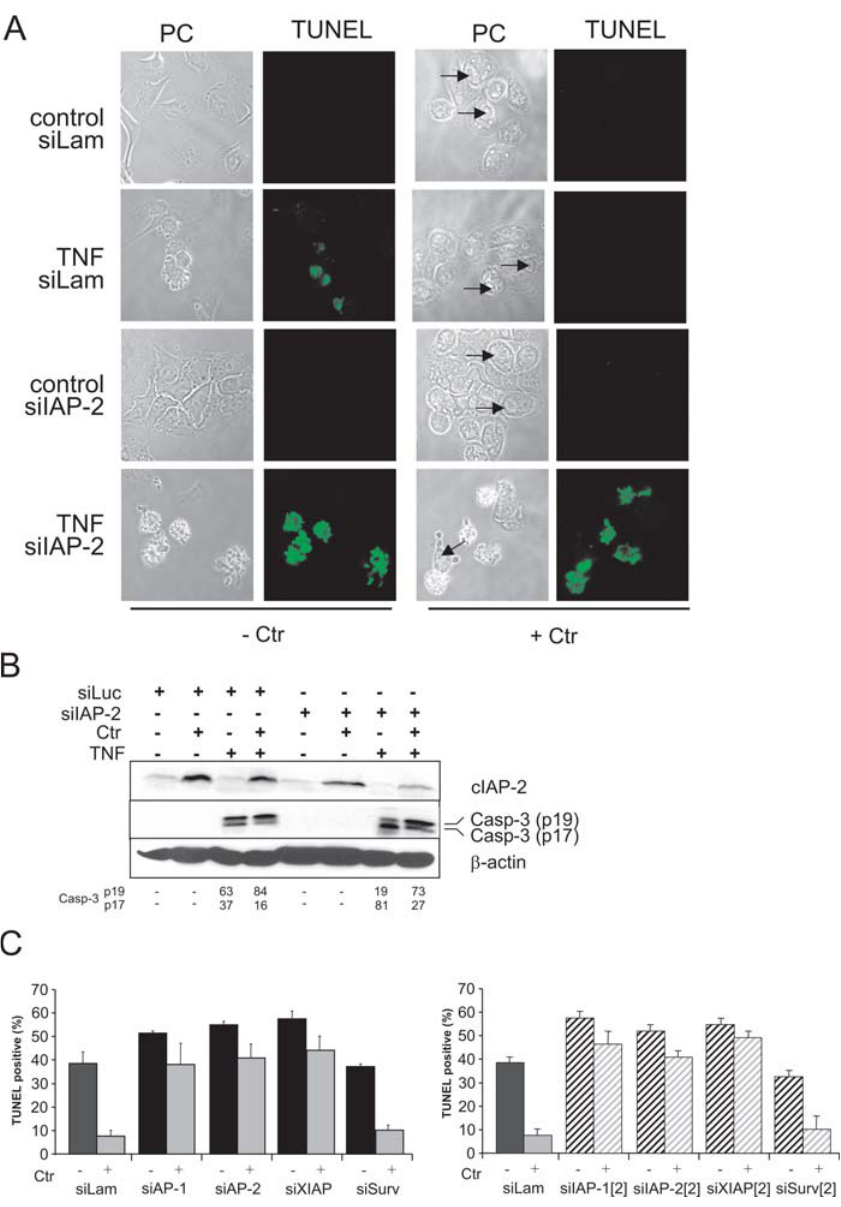
Figure 3. IAPs Required for Infection-Induced Apoptosis Resistance (A) HeLa cells were transfected with control siRNA (siLam) or siIAP-2 and infected ( þ Ctr) or not ( (cid:1) Ctr) with Ctr. Then, apoptosis was induced by treatment with TNF/CHX, and the apoptotic response was measured by phase contrast (PC) and TUNEL analysis. Arrows point to Ctr inclusions. (B) Infection-induced up-regulation of cIAP-2 prevents the processing of the caspase-3 p19 to the p17 fragment. HeLa cells were transfected with siRNAs, infected, and treated with TNF/CHX as indicated. cIAP-2 and the p19 and p17 fragment of caspase-3 were monitored by immunoblotting on the same membrane. The level of cIAP-2 in the siIAP-2 and TNF/CHX-treated infected sample roughly equals that of the uninfected siLuc and TNF/CHX- treated samples. Note that the proportion of the p19 and p17 fragments in these samples is similar but is clearly shifted in the other